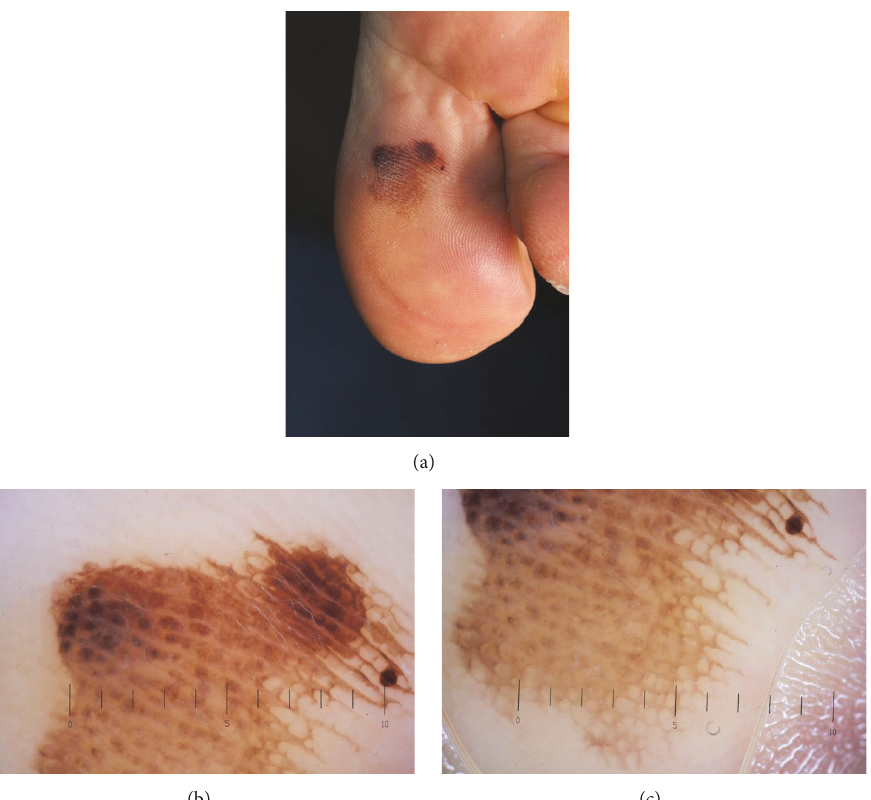
Figure 1: Clinical (a) and dermoscopic (b, c) features of the skin alteration. Notable is an asymmetric, irregular brown macula on the plantar side of the right hallux, approximately 15mm in diameter (a). In dermoscopy, border irregularity and parallel-ridge pattern showing light and dark brown pigmentation with intersecting connection lines being seen (b, c).